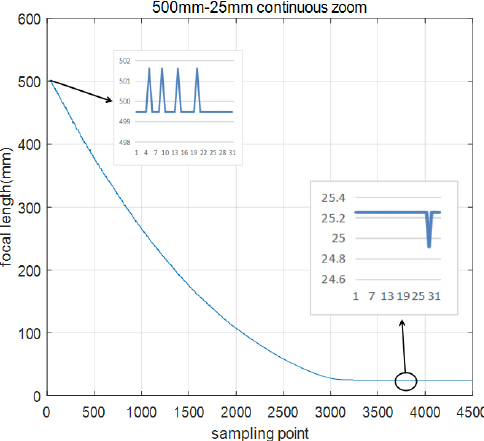
Figure 15. Zoom process from 500 mm to 25 mm.